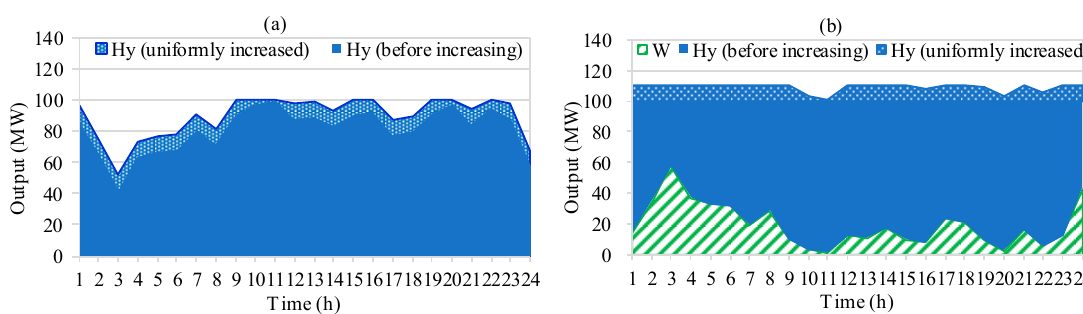
Figure 3. Diagram illustrating the hydropower output process being uniformly increased by 10 MW (assuming that increasing the hydropower output by 10 MW would reduce the generation amount gap and the hydropower maximum output is 100 MW). ( a ) Hydropower output processes before the increase and after being increased. ( b ) Wind power output combined with hydropower output processes in the left panel. Limited by the maximum output, the hydropower output at 10:00, 11:00, 15:00, 16:00, 19:00, 20:00, and 22:00 cannot be increased to larger than 100